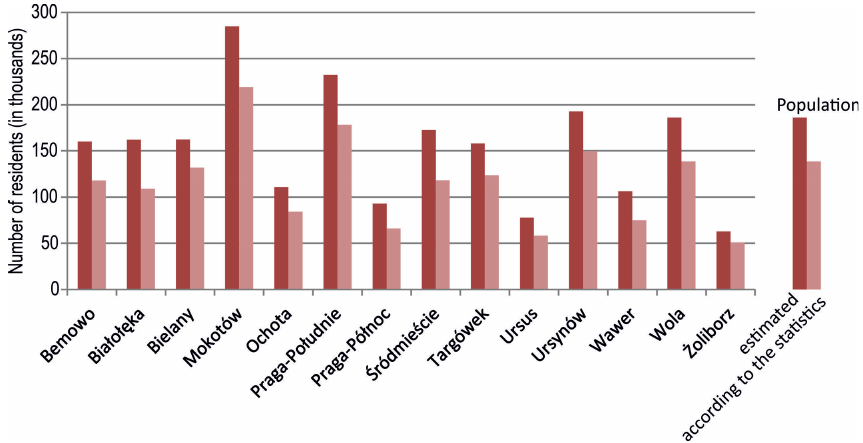
Fig. 3. Comparison of estimated population with official statistics (own